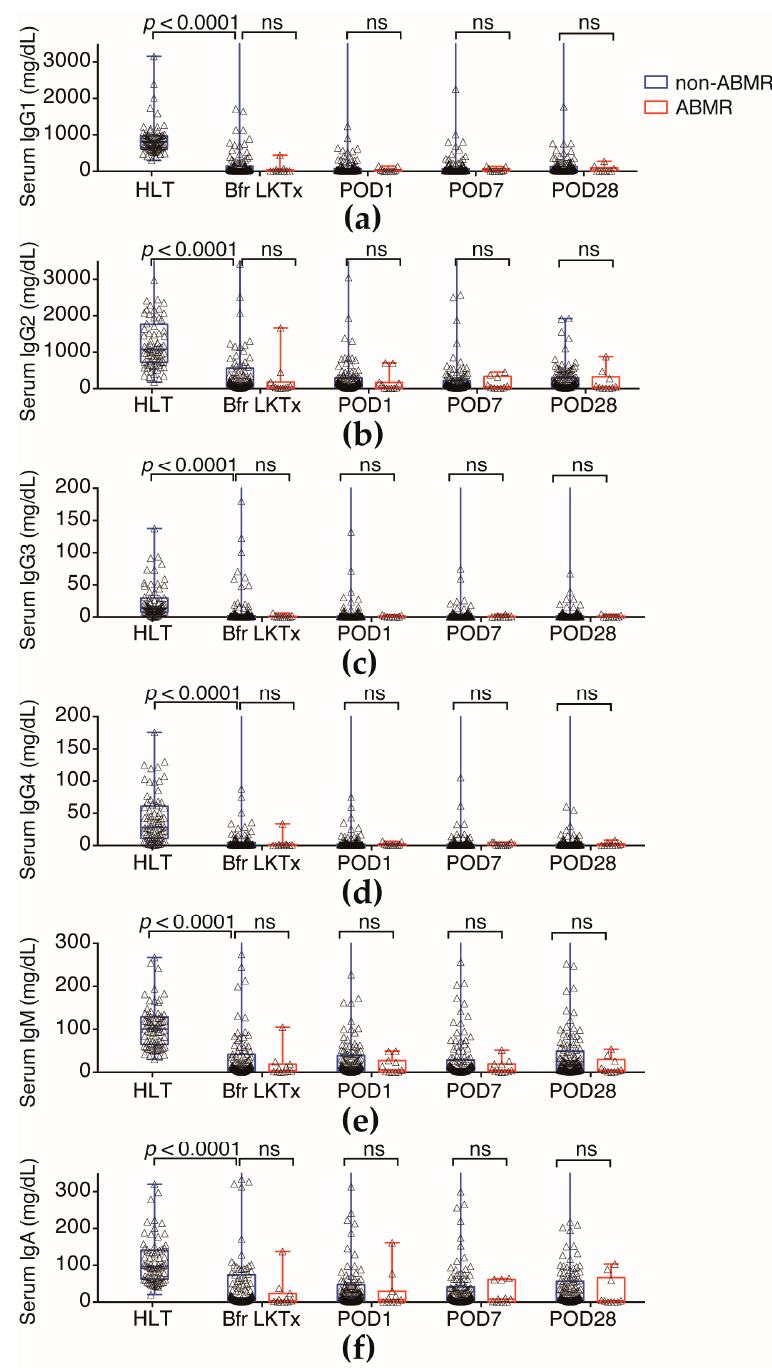
Figure 6. ( a ) Serum IgG1 levels in patients in HLT, non-ABMR, and ABMR patients; ( b ) Serum IgG2 levels in HLT, non-ABMR, and ABMR patients; ( c ) Serum IgG3 levels in HLT, non-ABMR, and ABMR patients; ( d ) Serum IgG4 levels in HLT, non-ABMR, and ABMR patients; ( e ) Serum IgM levels in HLT, non-ABMR, and ABMR patients; ( f ) Serum IgA levels in HLT, non-ABMR, and ABMR patients. All Igs levels in HLT were much higher than the LKTx group.